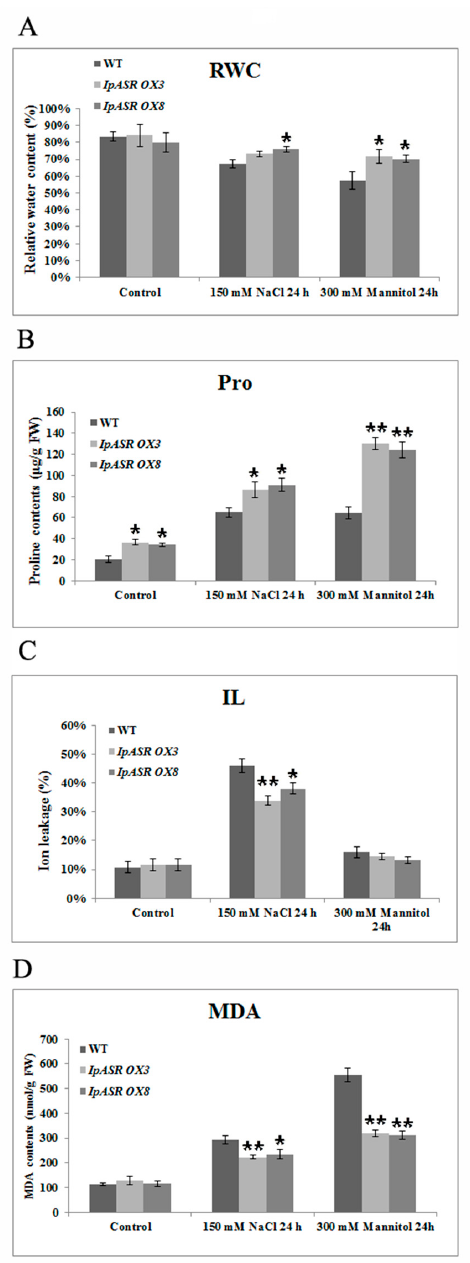
Figure 12. Changes in physiological parameters of IpASR overexpression Arabidopsis and WT seedlings (4 weeks) under 200 mM NaCl and 200 mM mannitol treatment for 24 h. ( A ) Relative water content (RWC); ( B ) Free proline content (Pro); ( C ) Ion leakage (IL); and ( D ) Malondialdehyde (MDA). Error bars indicate the SD based on over three replicates ( n ≥ 3). Asterisks indicate significant differences from the control (Student’s t -test p values, * p < 0.05 and ** p < 0.01).